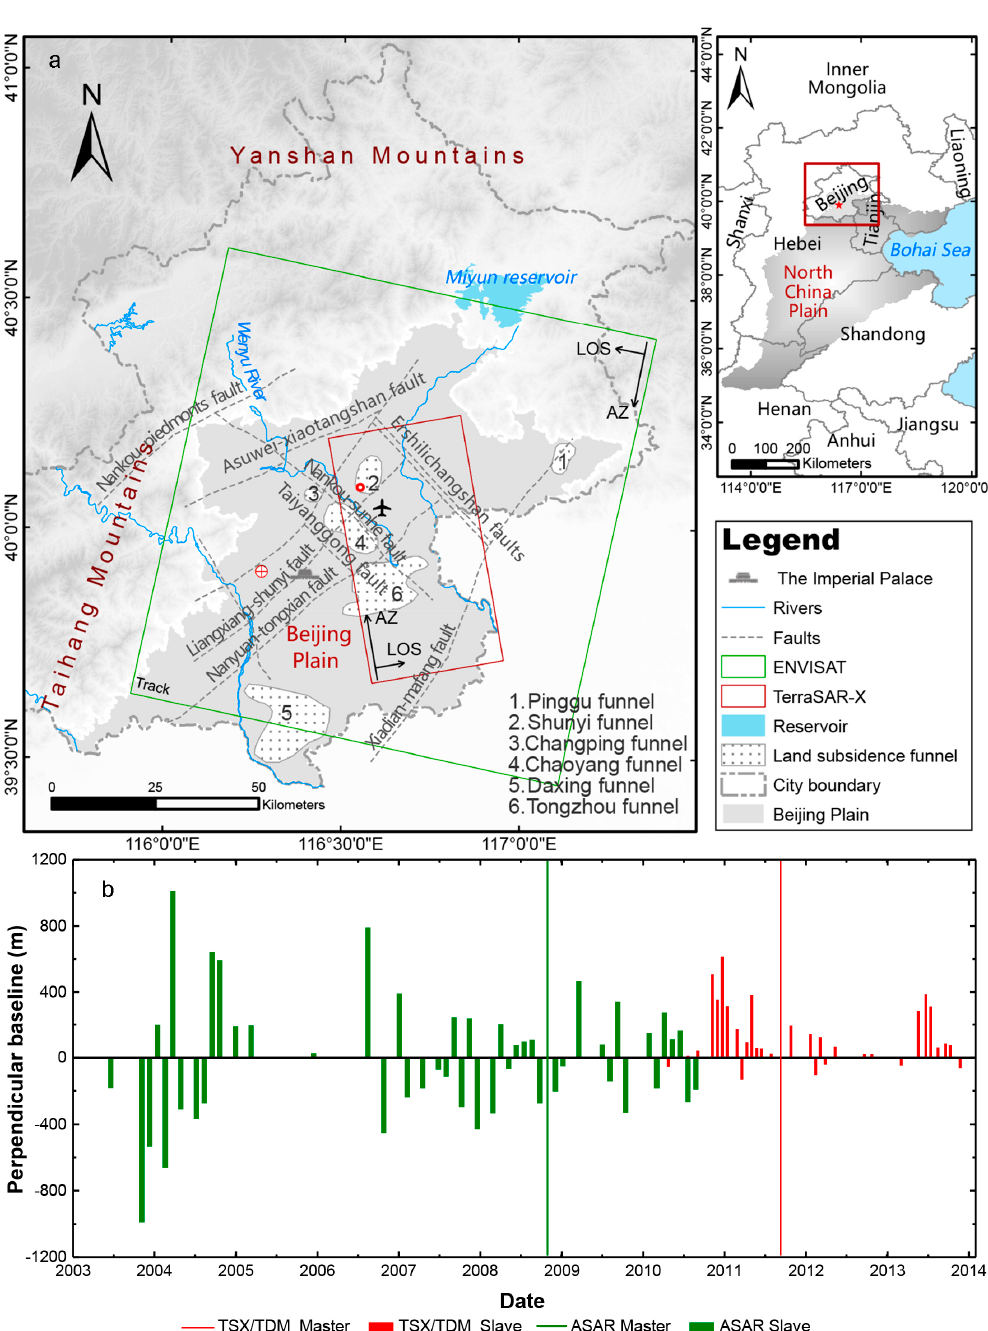
Figure 1. ( a ) The location of Beijing Plain and the coverage of the SAR sensors. The light gray dashed lines are the main faults published by CGS, and the labels indicate the name of the active faults mentioned in this study. The red circle with cross is the reference point. The red circle is the location of Houshayu, while the black bold plane represents the Beijing Capital International Airport. ( b ) Temporal–spatial baseline distributions of Envisat ASAR and TerraSAR-X image stacks in this study. TSX/TDM is the abbreviation of TanDEM-X/TerraSAR-X.